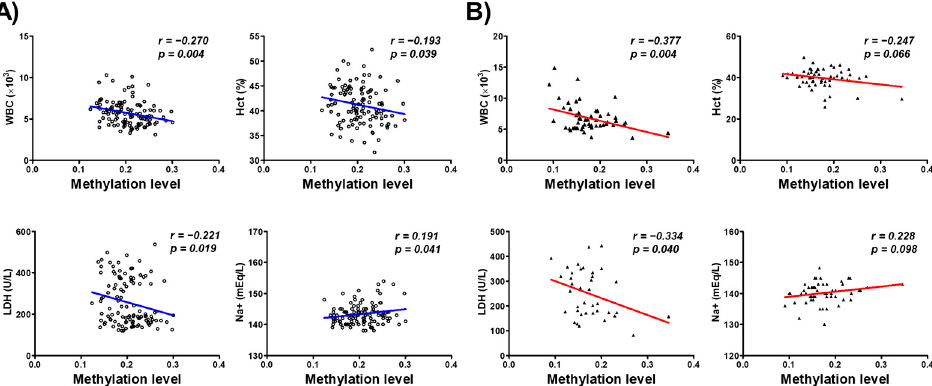
Figure 3. Analysis of the association between methylation of the CYP26C1 promoter region and blood parameters in normal and SVO subjects. WBC—white blood cell; Hct—hematocrit; LDH—lactate dehydrogenase; Na + —natrium. ( A ): Normal subjects; ( B ): SVO subjects. Red line and Blue line: linear regression between methylation of the CYP26C1 promoter region and blood